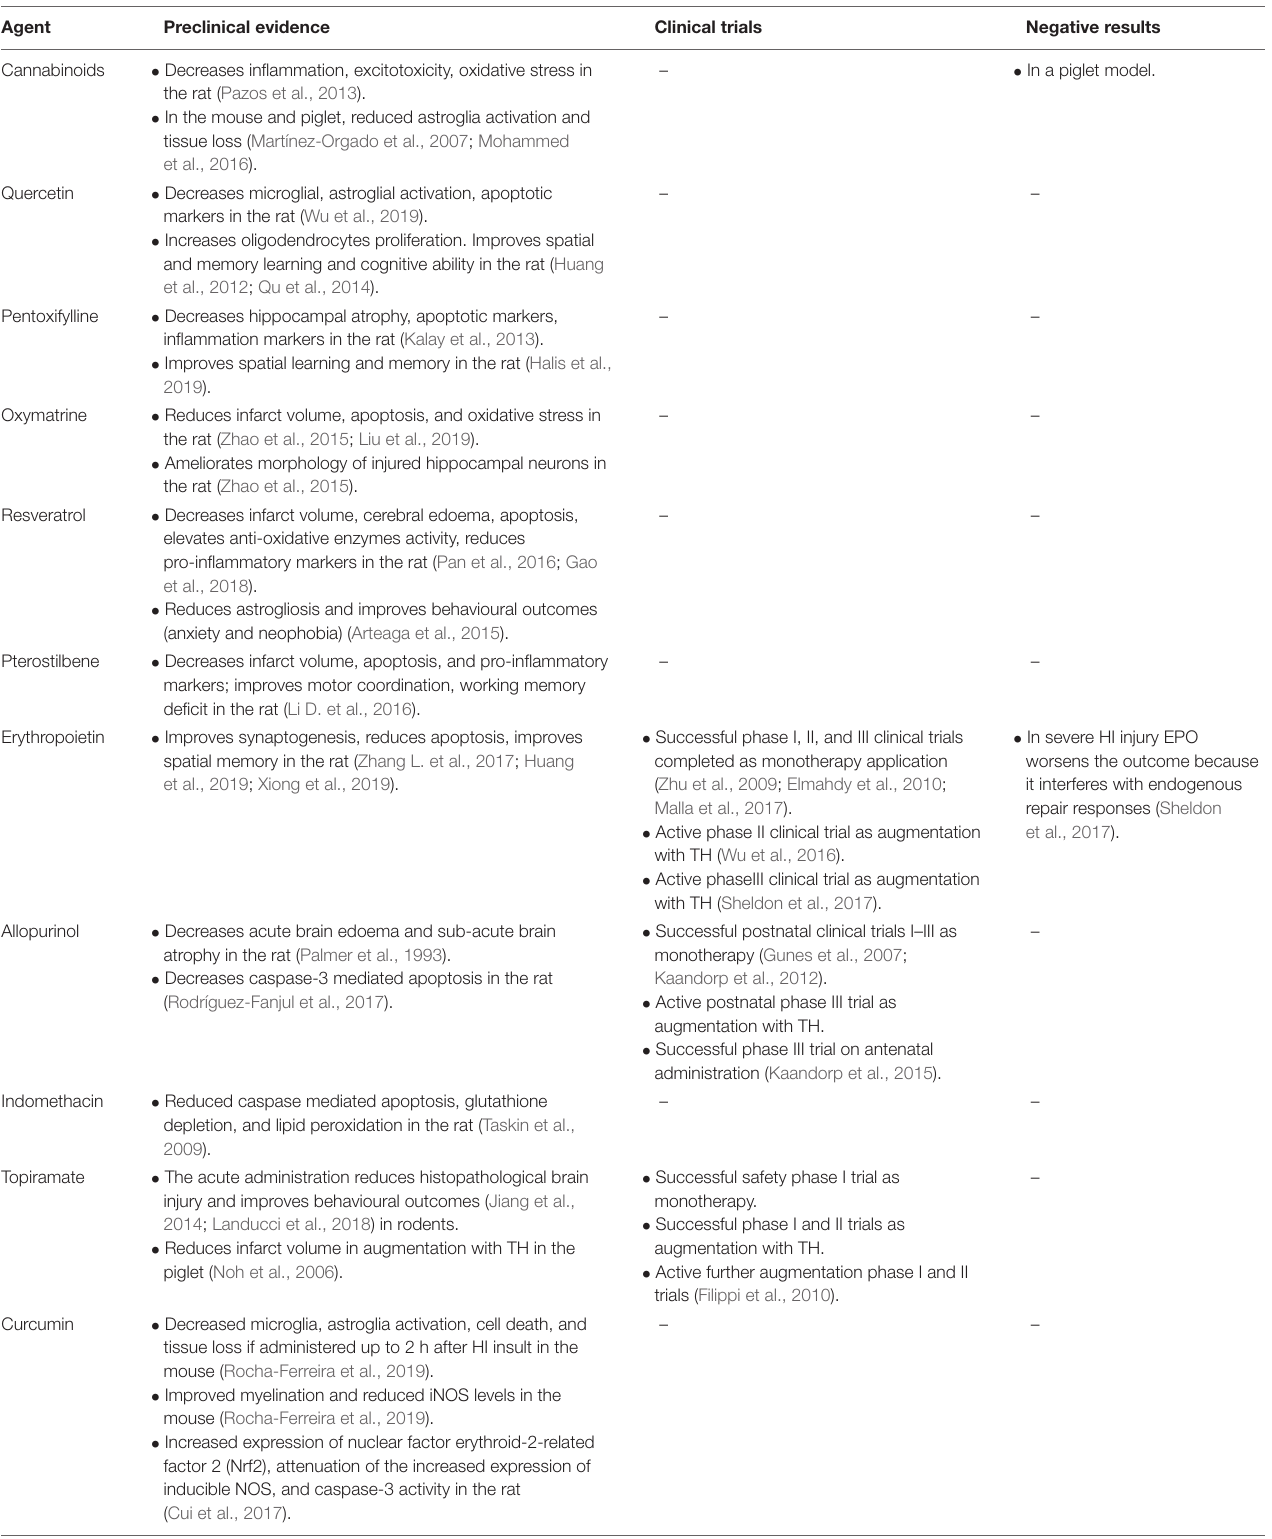
TABLE 1 | Summary of neuroprotective agents for neonatal brain injury in pre-clinical studies and in clinical trials. Agent Preclinical evidence Clinical trials Negative